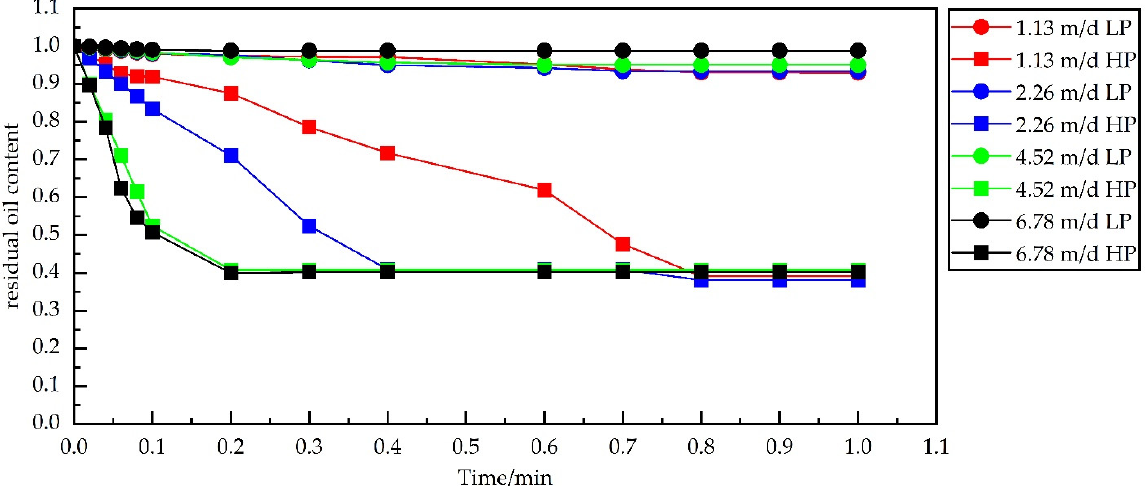
Figure 8. Residual oil volume versus time in the high and low permeable zones for Chip 1 at different inlet flow rates. LP represents low permeable zone, HP represents high permeable zone.